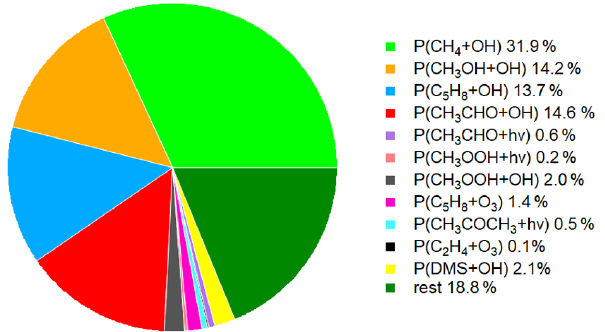
Figure 6. Chemical production terms of HCHO during CYPHEX, including daily averages of all